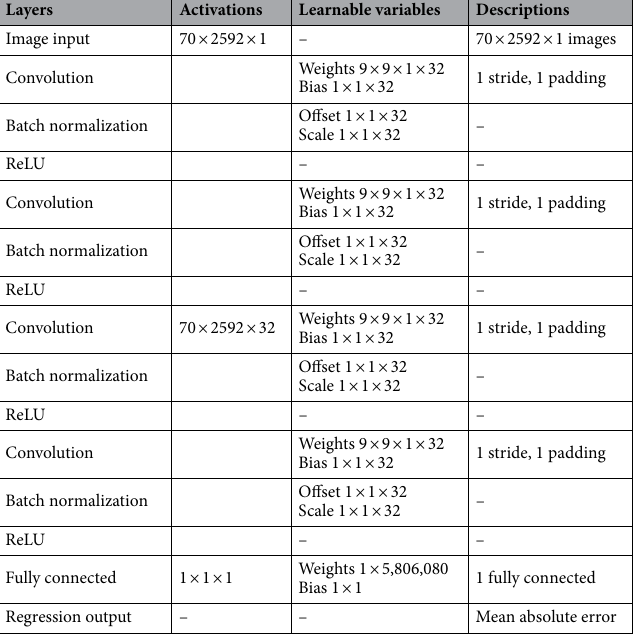
Table 1. The proposed convolutional neural network